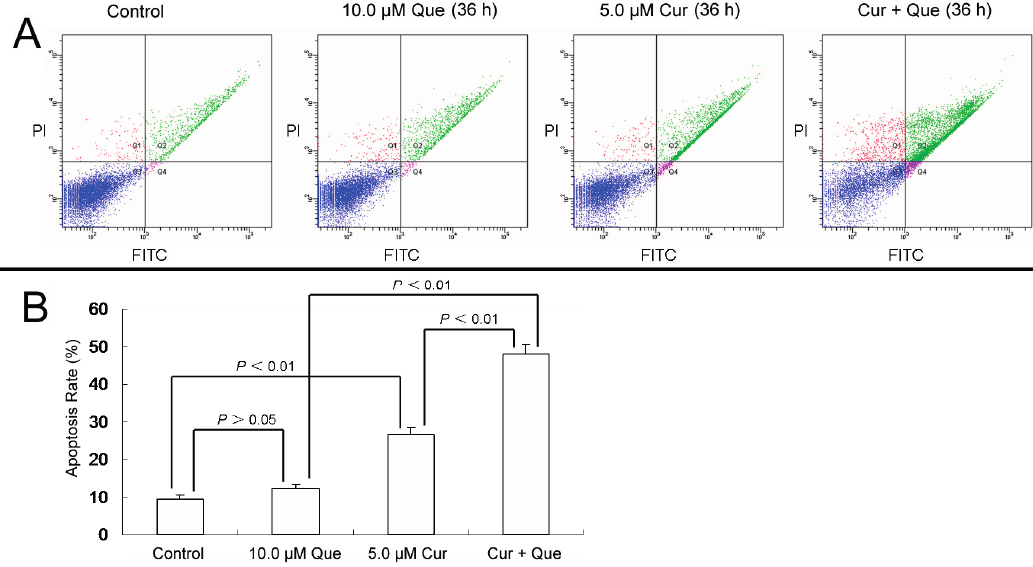
Figure 2. Combination of quercetin and curcumin significantly triggered apoptosis of MGC-803 cells. MGC-803 cells were treated with quercetin (10.0 µM), curcumin (5.0 µM) or a combination of the two for 36 h. Apoptosis rates were then measured by flow cytometry. ( A ) Apoptosis induced by quercetin and/or curcumin in MGC-803 cells. ( B ) Data analysis of ( A ). Values are expressed as mean ± SD of three determinations. p < 0.05 and p < 0.01 represent a significant difference among groups. Que and Cur are abbreviations of quercetin and curcumin,